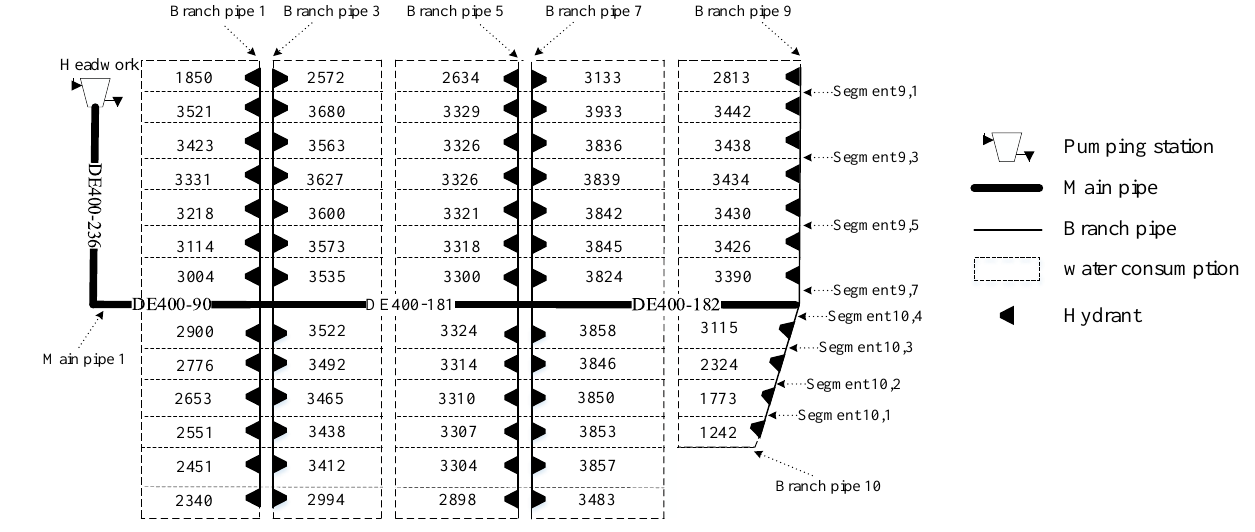
Figure 5. Diagram of the experimental field. Table 2. The diameters of all branch pipe segments in the experimental field. Since there are too many pipe sections in the experimental field, in order to facilitate the mathematical description, this paper describes the pipe sections as two-dimensional data. Sort by branch number and assign values to all pipe segments of each branch.